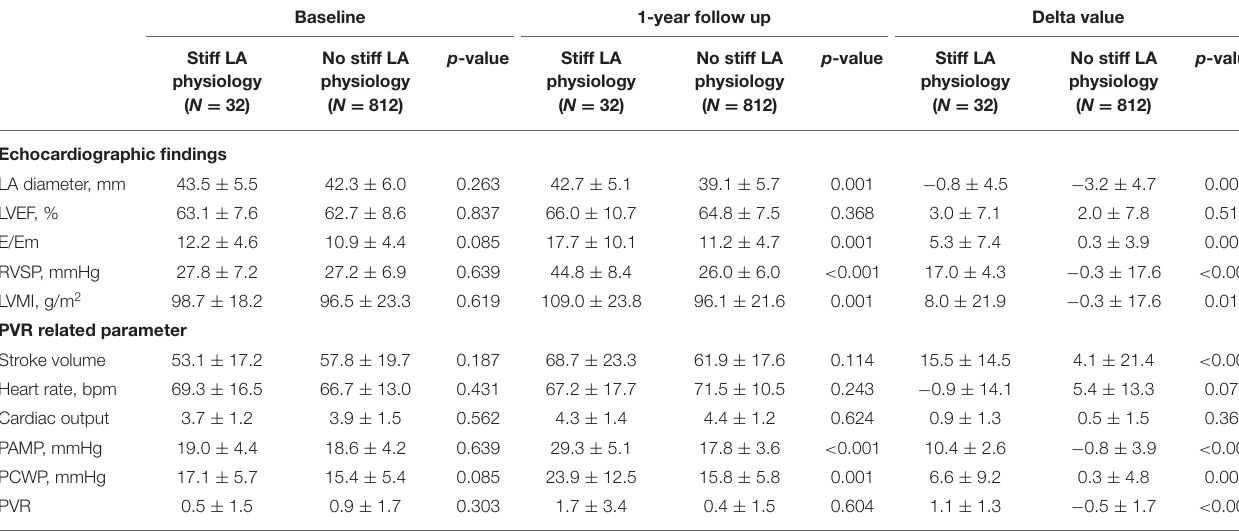
TABLE 2 | Echocardiographic characteristics according to the presence of a stiff LA physiology. Baseline 1-year follow up